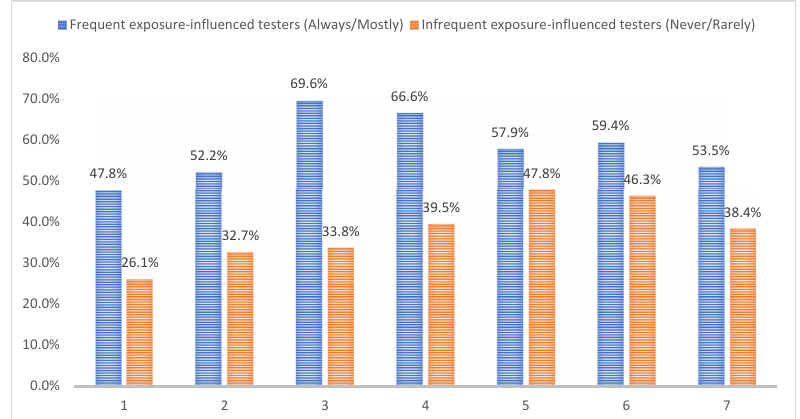
Figure 1. Proportions of YMSM reporting high/moderate (vs. low/no) intention of seeking future exposure-influenced HIV testing by various risky sex scenarios among previously frequent (n = 69)